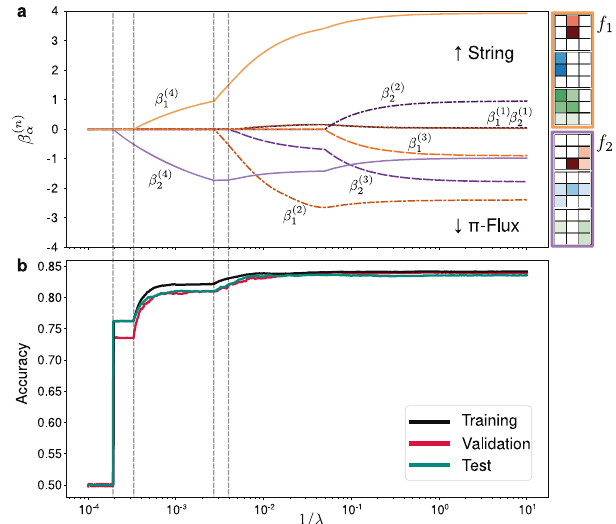
Fig. 3 Regularization path analysis of a learned fourth-order model. a The regularization path of β ð n Þ α coef fi cient values traced out by two learned fi lters as a function of the inverse regularization strength 1/ λ . Positive and negative signs of β ð n Þ α are associated with geometric string and π - fl ux labels respectively. b The accuracies of the model at each point of the regularization path in ( a ) on both the training dataset, as well a validation dataset unseen by the model during training and a test dataset unseen by us until fi nal evaluation. We use the standard de fi nition of accuracy as the fraction of the snapshots correctly